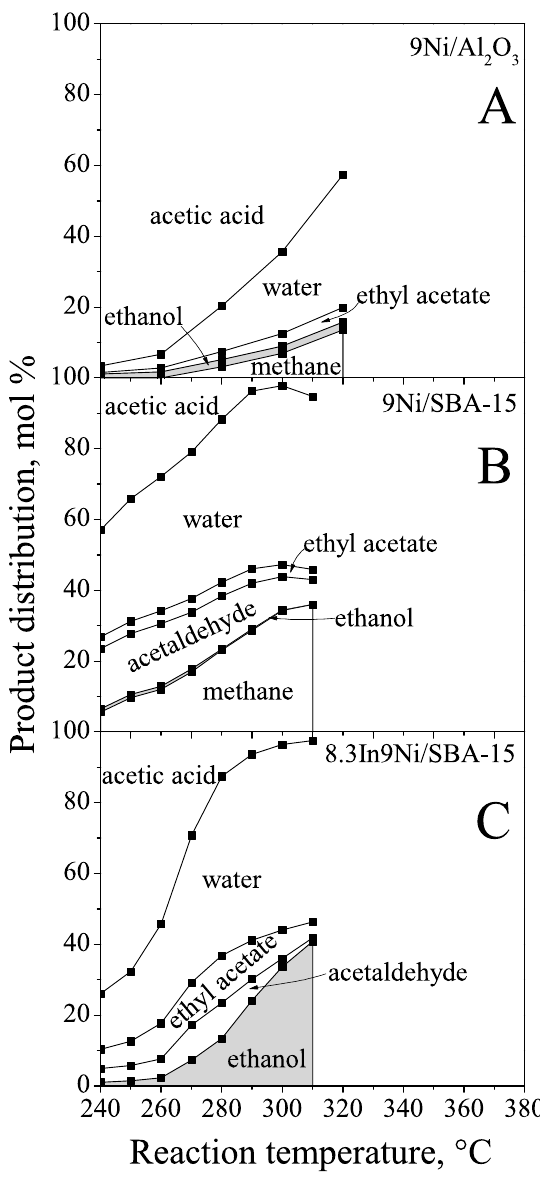
Figure 3 : Product distribution of AA hydroconversion as a function of reaction temperature over monometallic nickel on (a) Al and bimetallic nickel-indium on (c) SBA-15 catalysts at 21 bar total pressure and 1 g /g × h WHSV using stacked area AA cat.